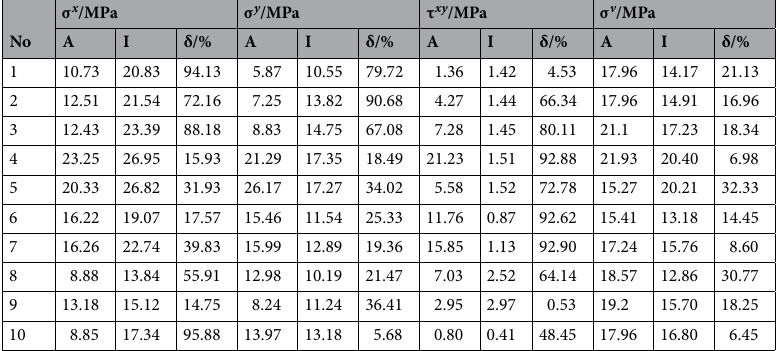
Table 3. Comparison between calculated and measured in-situ stresses based on isotropy.